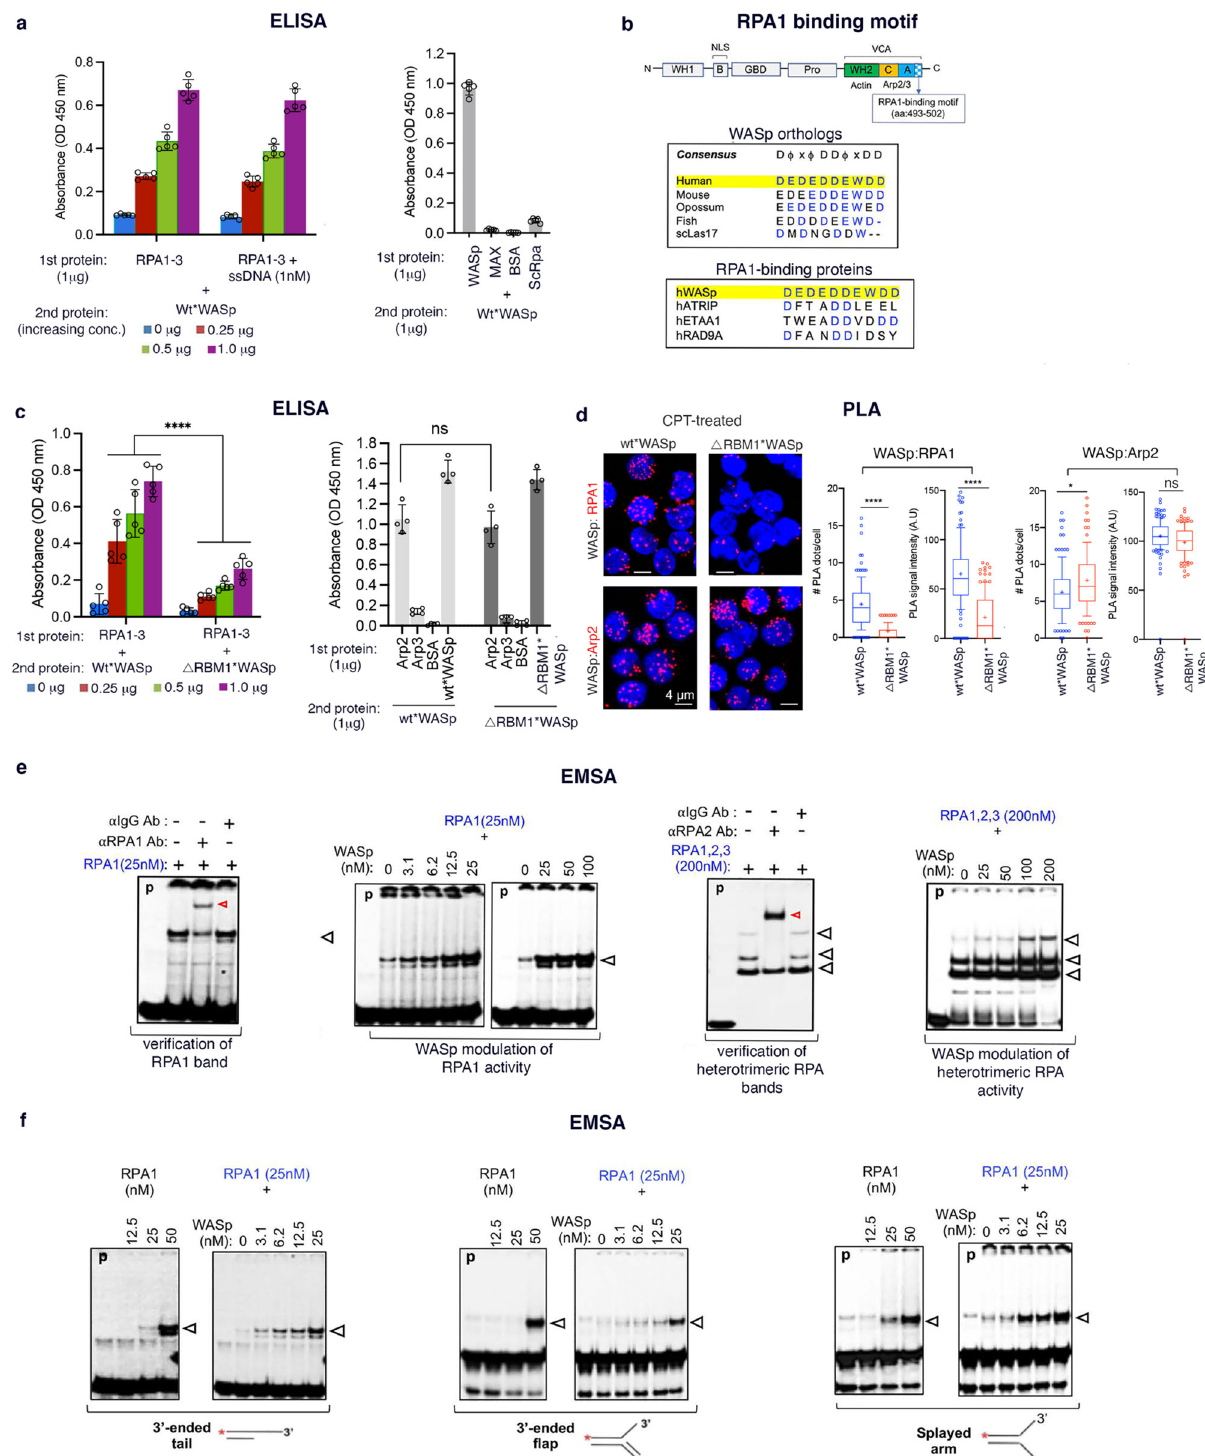
de fi cient (WKO) T cells (Supplementary Fig. S3b) and show by the PLA method in the FACS-enriched GFP-expressing T cells that the in vivo binding of transfected Δ RBM1 * WASp with endogenous RPA1 is signi fi cantly lower relative to that of trans- fected WT * WASp after 2 h of CPT treatment (Fig. 2d). In con- trast, transfected Δ RBM1 * WASp can still bind endogenous Arp2 in the cytoplasm and nucleus (PLA signals captured in both sub- compartments; cytoplasmic PLA signals appear to be con- centrated in the region typically occupied by Golgi